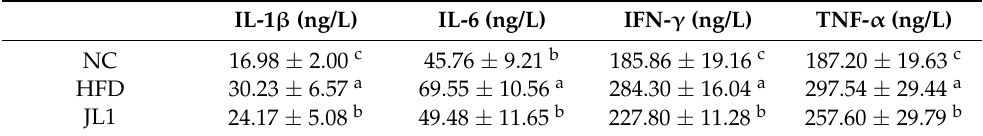
Table 5. Effect of L. rhamnosus JL1 on the levels of serum inflammatory cytokines in mice.